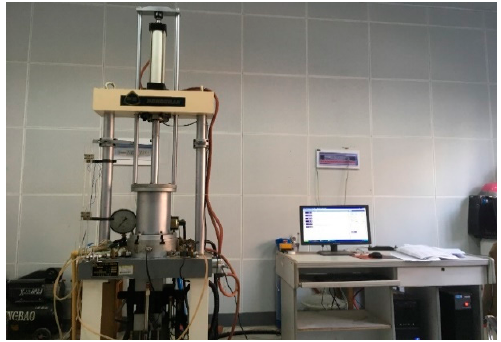
Figure 1. TYD ‐ 20 dynamic triaxial test apparatus. Figure 1. TYD-20 dynamic triaxial test